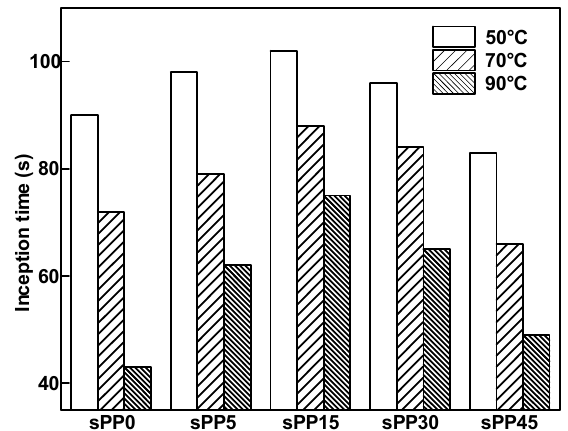
Figure 3. Inception time of electrical tree for isotactic polypropylene (iPP)/syndiotactic polypropylene (sPP) blends at 50, 70, and 90 °C.